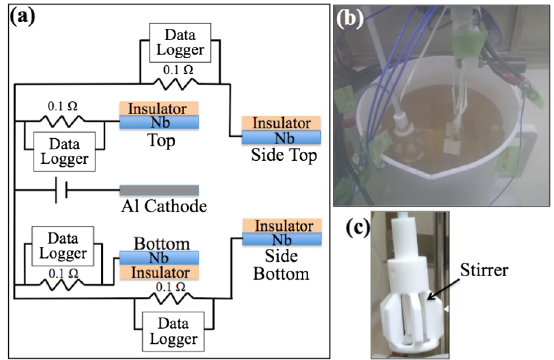
FIG. 4. (a) Schematic showing the arrangement of Nb samples near the Al cathode and electrical connections to measure EP currents from individual samples, (b) EP bath, and (c) stirrer for the acid